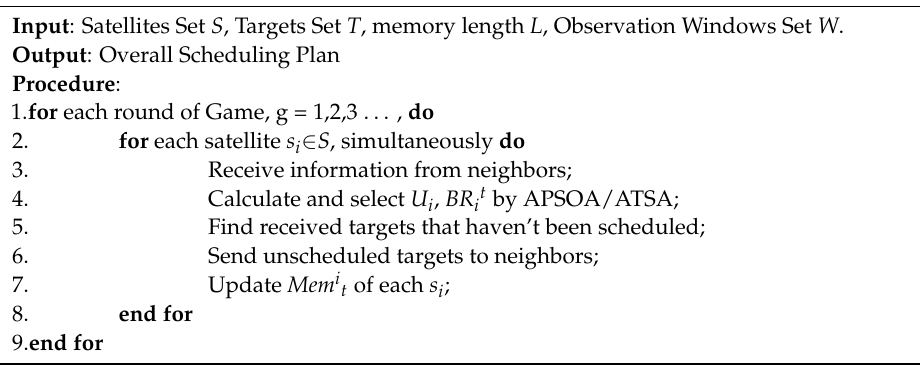
Algorithm 1 DMSA